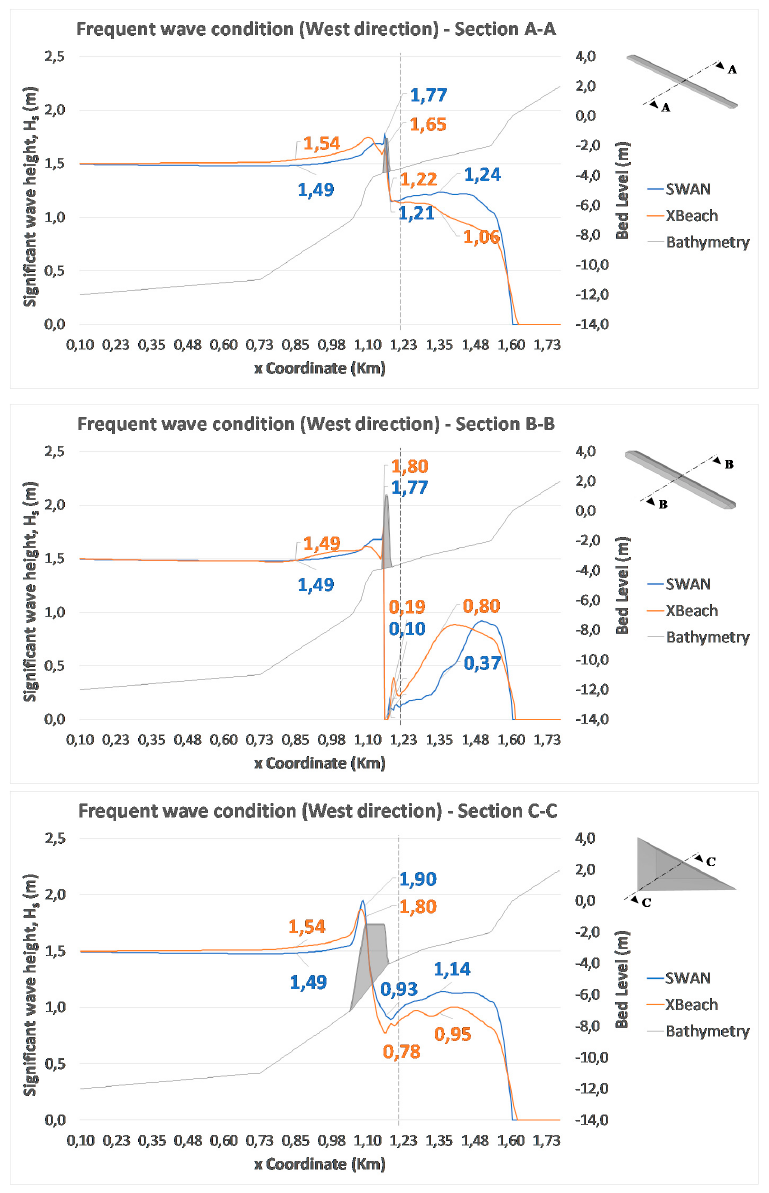
Figure 7. Comparison between the SWAN and XBeach significant wave height results for frequent wave condition (west direction): submerged detached breakwater (section A-A), emerged detached breakwater (section B-B), and MFAR (Section C-C).